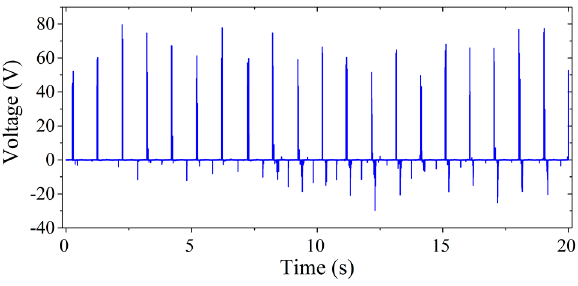
Figure 14. Output voltage of WearETE during harvesting energy from human